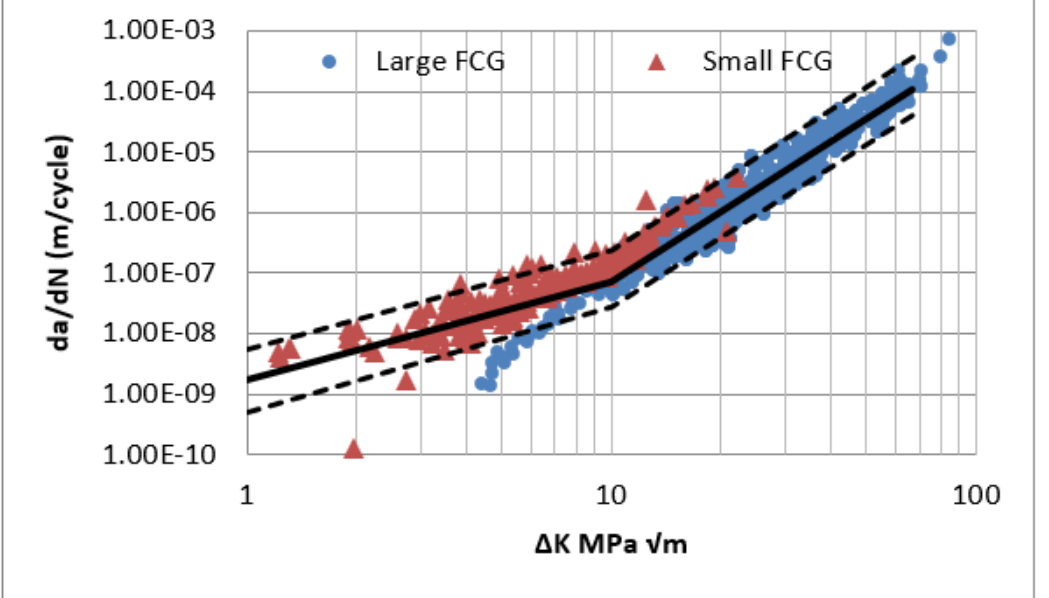
Figure 7. Ti-6Al-4V bilinear Paris equation for small [34 – 36] and large [9,33] crack growth rates.